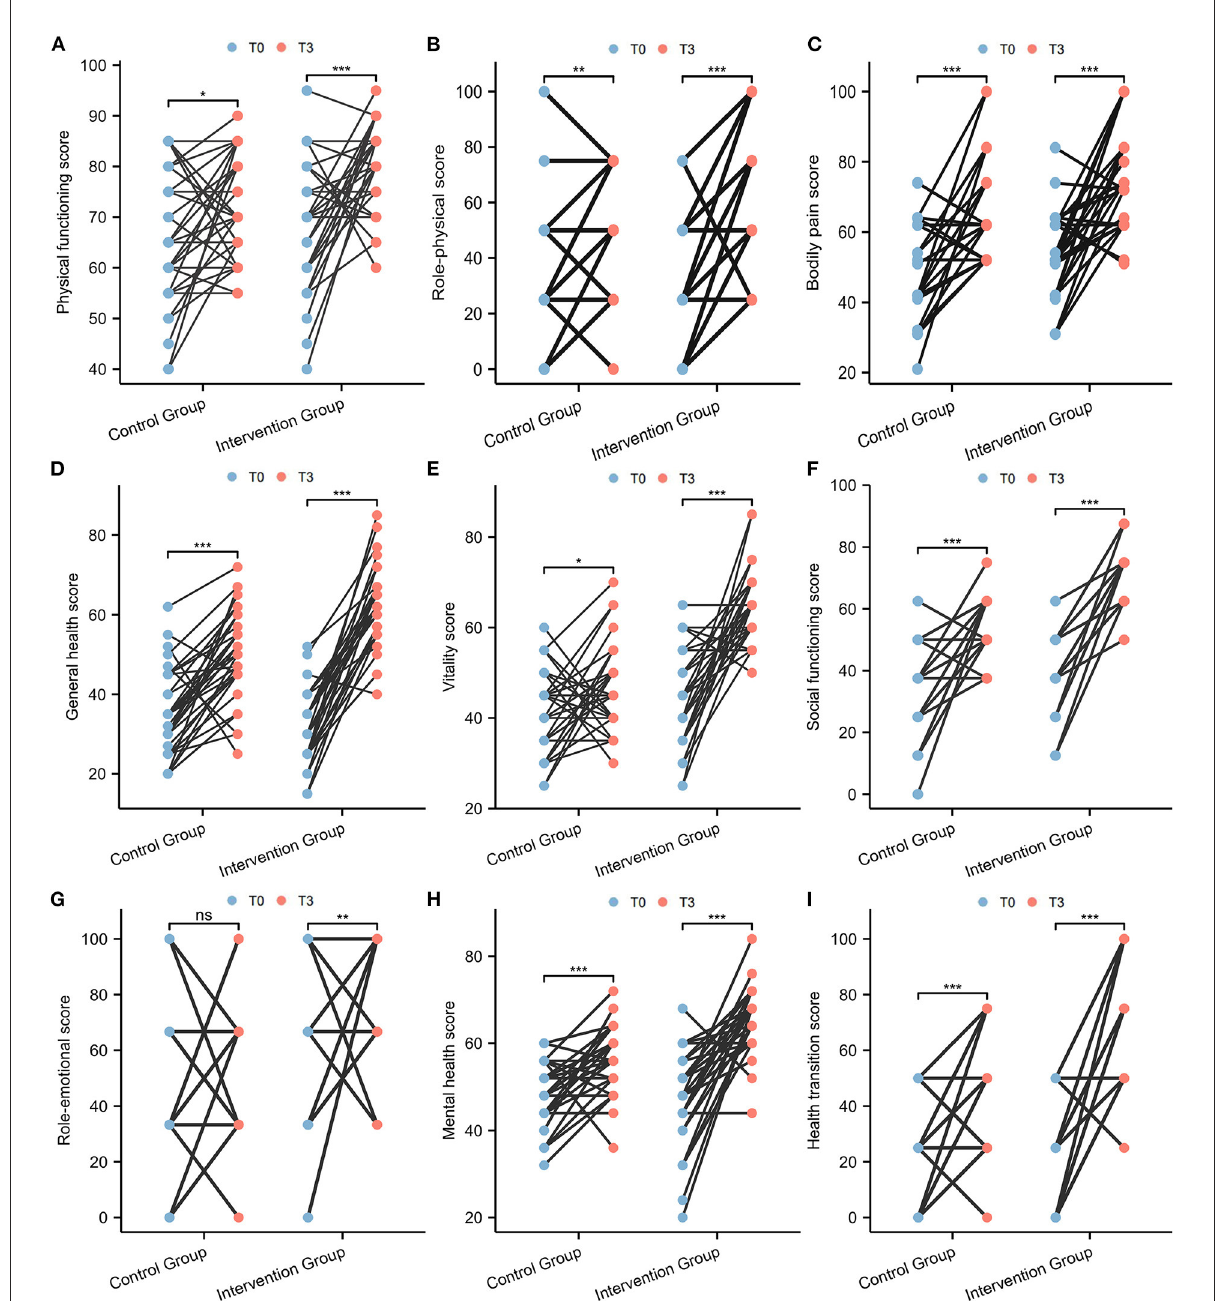
FIGURE3 Comparison of SF-36 scale scores between T0 and T3 in paired samples. (A) Physical functioning; (B) Role physical; (C) Bodily pain; (D) General health; (E) Vitality; (F) Social functioning; (G) Role emotional; (H) Mental health; (I) Health